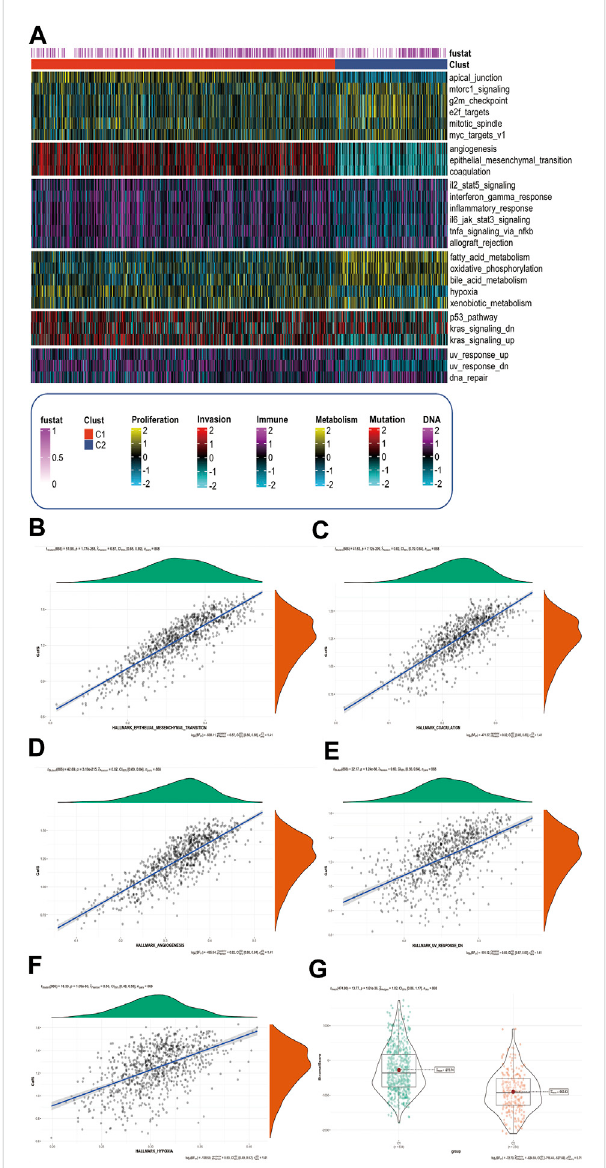
sample gene set enrichment analysis (ssGSEA) method to